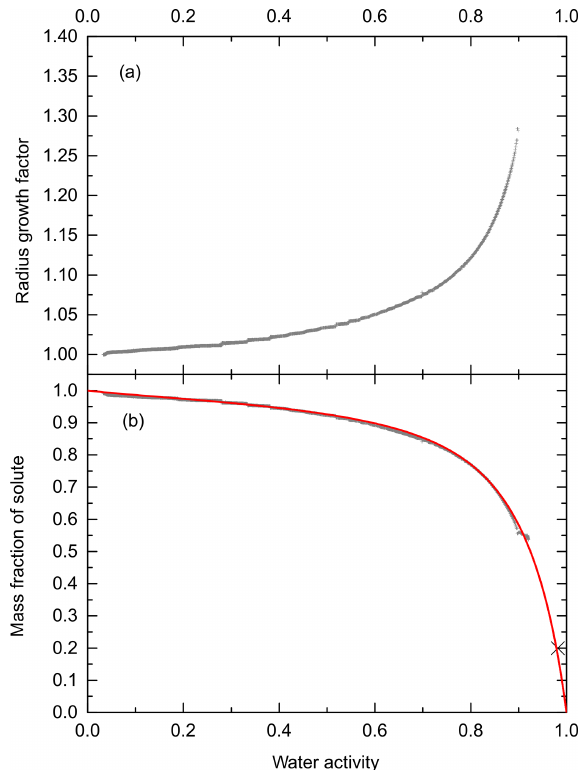
Figure A5. (a) Radius growth factor of a 3-MBTCA particle at 290K as derived from Mie resonance spectroscopy (light-gray crosses) and from mass balance (dark gray crosses) using 1 . 428 ± 0 . 05gcm − 3 for the density of the pure solute to convert from mass to size. (b) Mass fraction of solute vs. water activity calculated from the data of panel (a) . The black cross represents a dew point mea- surement of a bulk solution. The red line represents the fit according to Eq. (A12).